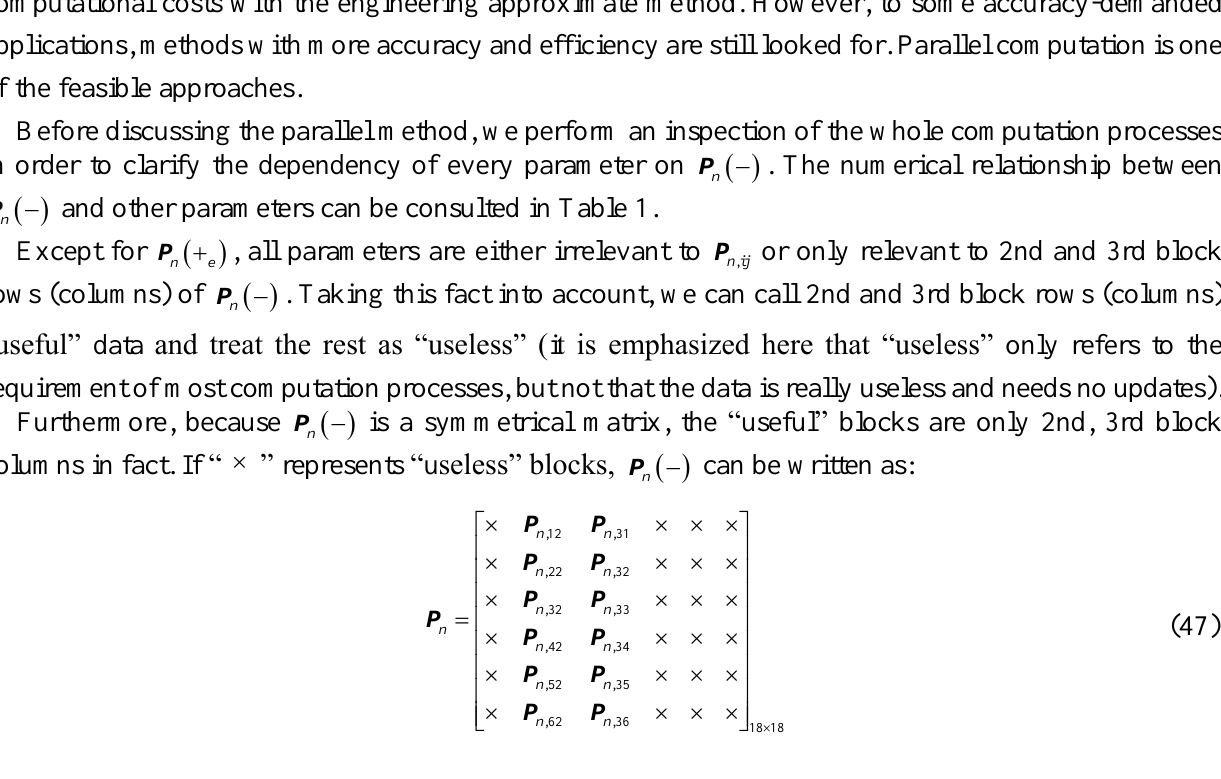
Table 1. Dependency of every real-time parameter on  